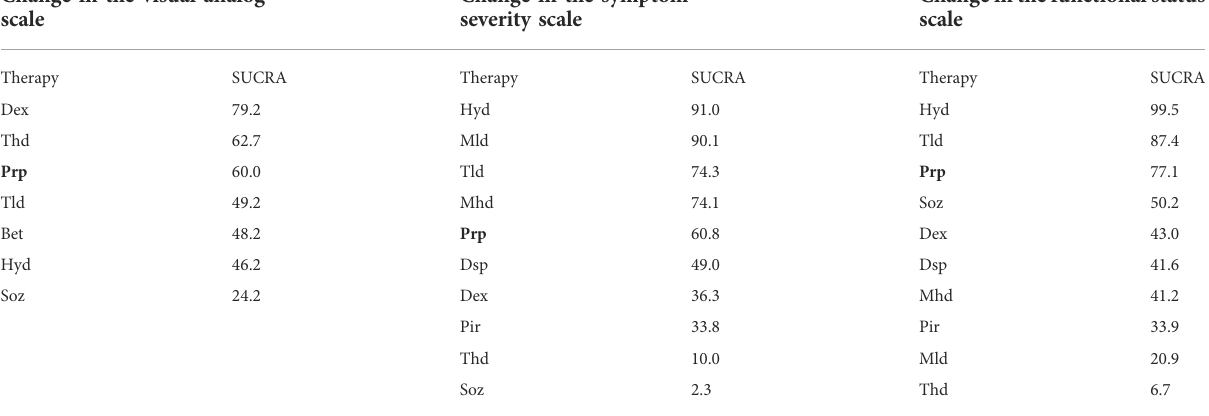
TABLE 2 Summary results of all SUCRA values. Change in the visual analog